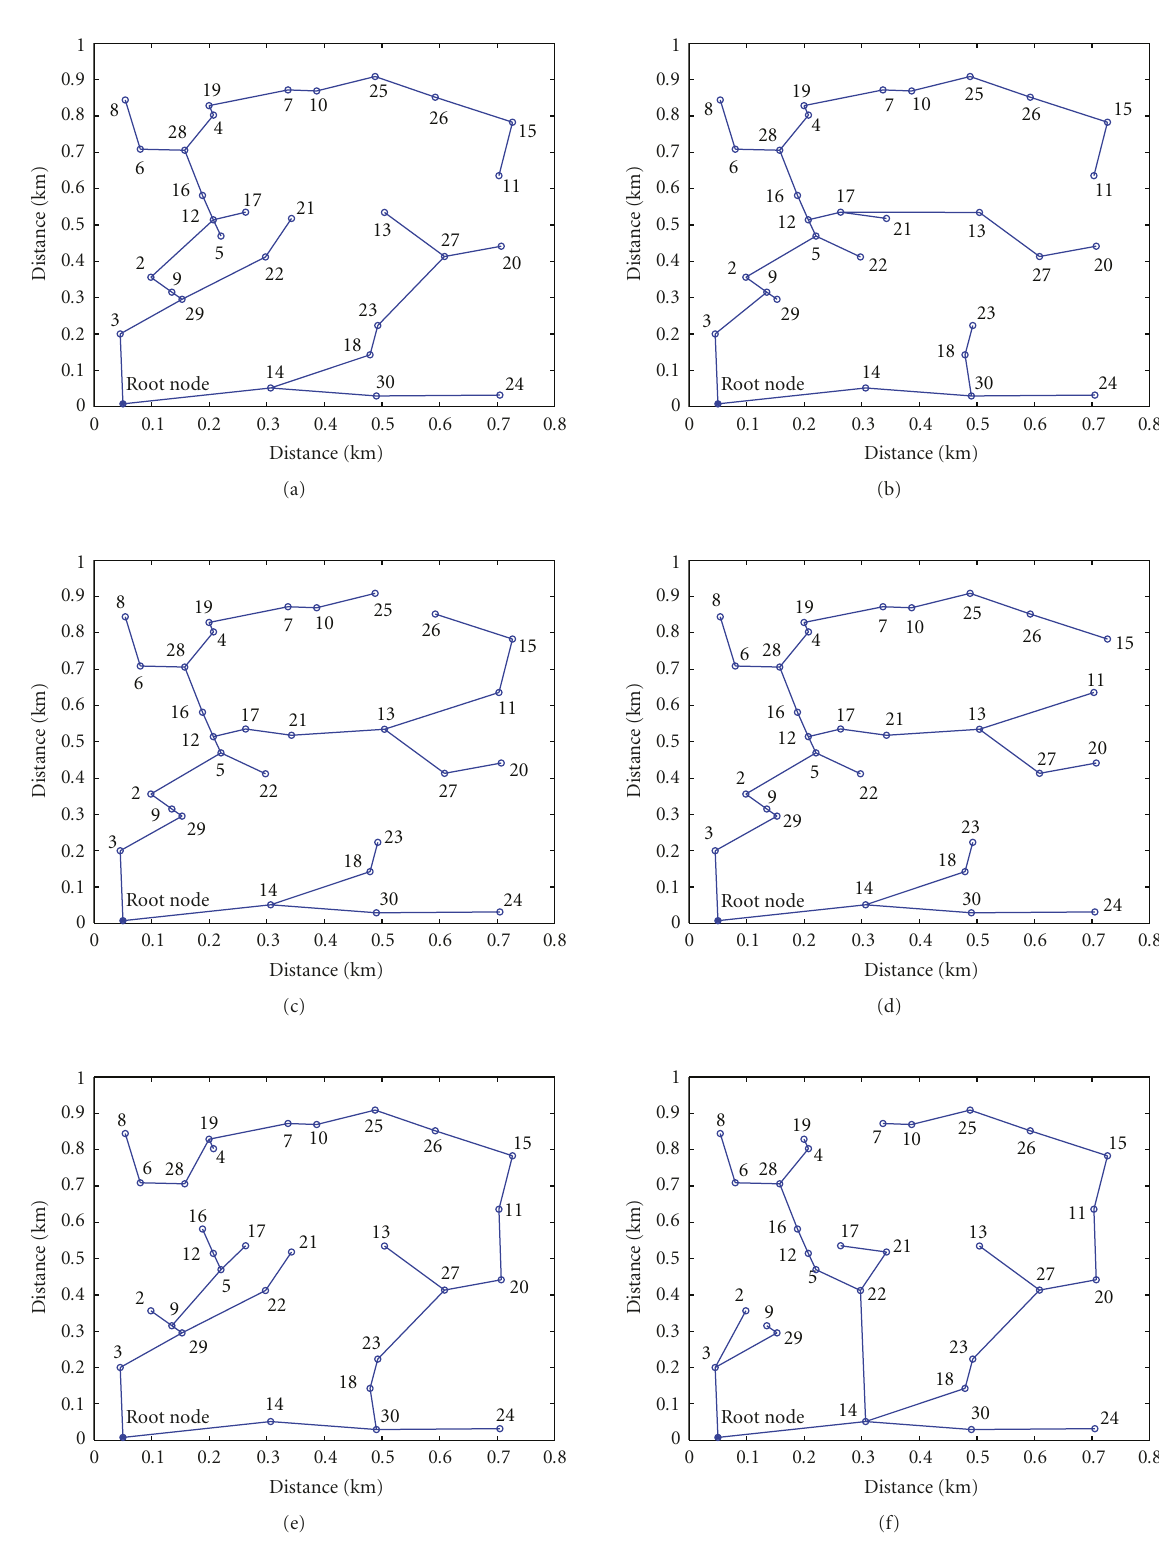
Figure 8: Spanning trees constructed by the di ff erent schemes with the assumptions being as follows: 30 nodes (including the root node shown by star) uniformly distributed in a 1 × 1km plane, path loss exponent is 3, γ = 5dB, (a) interference aware pruning routing (IAPR) (15 pruning operations) ( S = 17), (b) randomized interference aware pruning routing (IAPR) ( P = . 01) ( S = 16), (c) weighted power and interference routing (WPIR) ( β = 0 . 5) ( S = 19), (d) minimum power routing (MPR) ( S = 19), (e) minimum neighbors routing (MNR) ( S = 17), and (f) interference routing (IR) ( S =